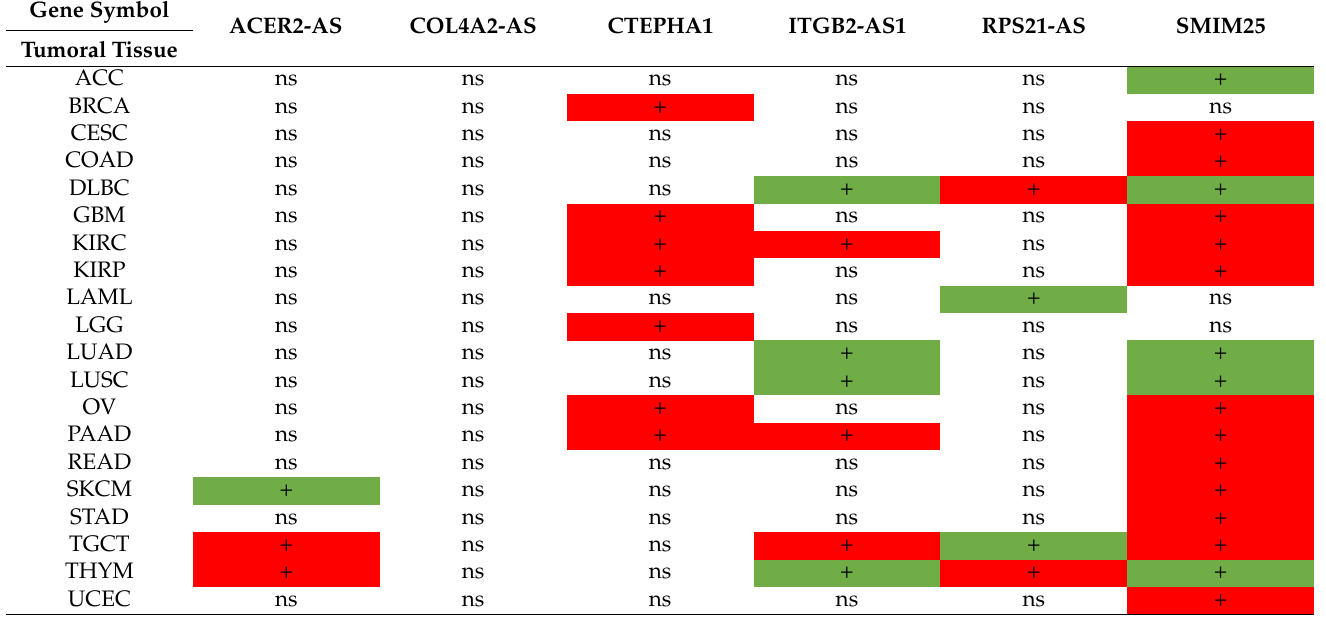
Table 2. Correlation of DE lncRNAs with expression in cancer. Deregulation has been investigated in tumoral versus healthy tissue using GEPIA2 database and reported as ns (non-significant deregulation), a green + (upregulation in normal tissue) and a red + (upregulation in tumoral tissue). ACC: Adrenocortical carcinoma; BRCA: Breast invasive carcinoma; CESC: Cervical squamous cell carcinoma and endocervical adenocarcinoma; COAD: Colon adenocarcinoma; DLBC: Lymphoid neoplasm diffuse large B-cell lymphoma; GBM: Glioblastoma Multiforme; KIRC: Kidney renal clear cell carcinoma; KIRP: Kidney renal papillary cell carcinoma; LAML: Acute myeloid leukemia; LGG: Brain lower grade glioma;